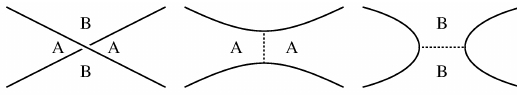
Fig. 2. The A- and B-corners of a crossing, and its both splittings. The corner A (respectively B) is the one passed by the overcrossing strand when rotated counterclockwise (respectively clockwise) towards the undercrossing strand. A type A (resp. B) splitting is obtained by connecting the A (resp. B) corners of the crossing. The dashed line indicates the trace of the crossing after the split.